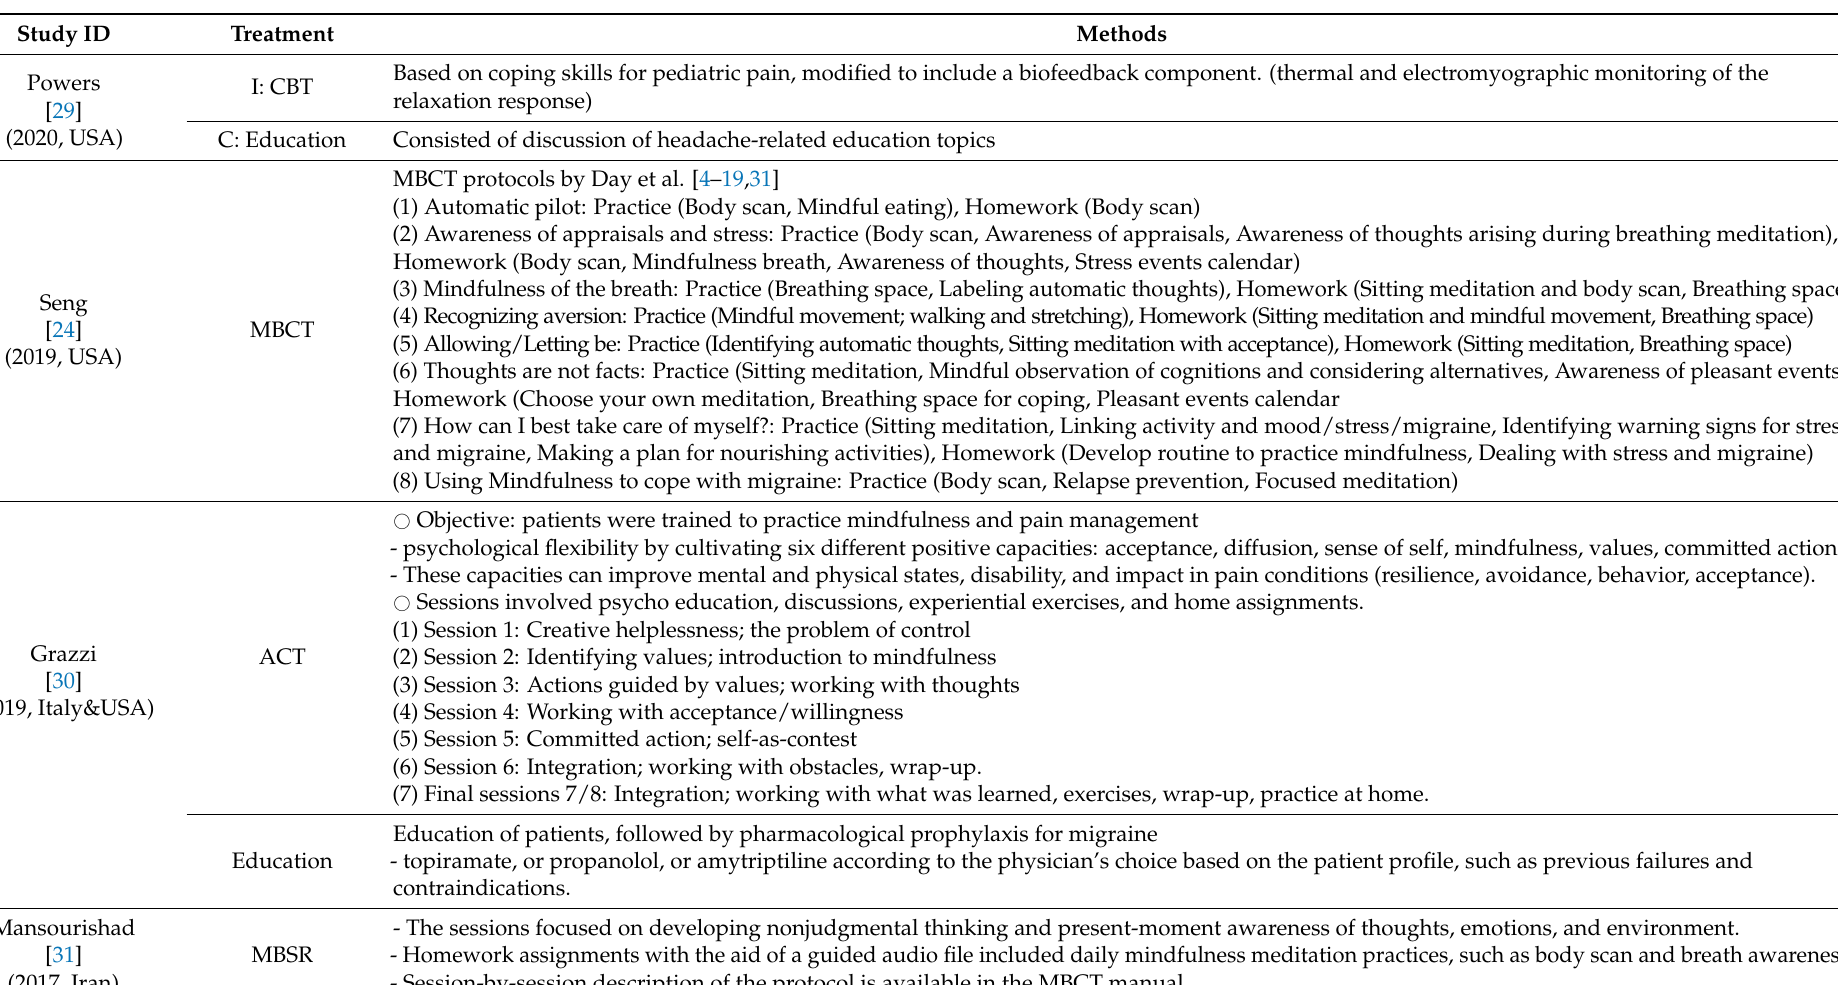
Table 2. CBT methods of the included